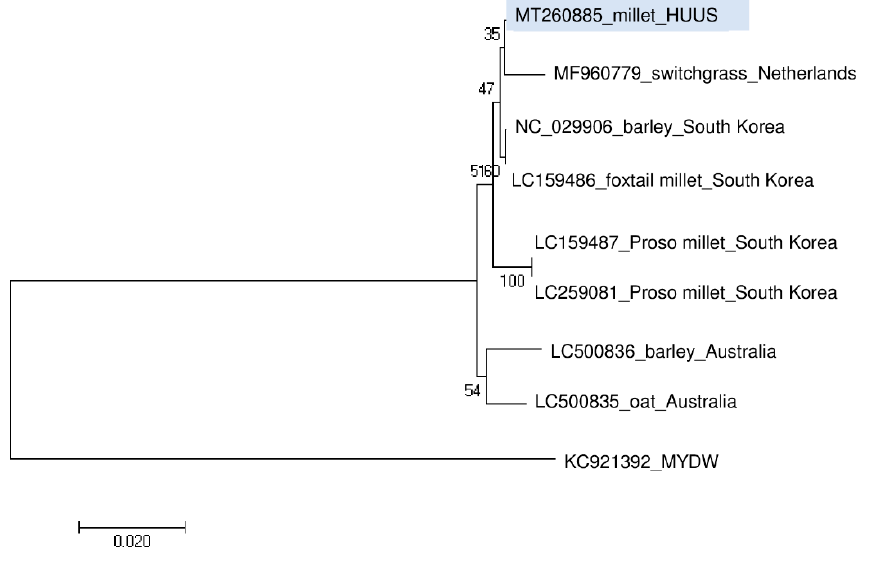
Figure 5. Results of the barley virus G (BVG) detection by sRNA HTS. ( a ) Genome organization of BVG, highlighting its coding regions and the position of the primers which were used in the RT-PCR. ( b ) shows coverage of the genome by the sequenced BVG-specific sRNA reads. The blue color shows sRNA in sense, while the red color shows sRNAs in antisense orientation. ( c ) shows size distribution of the sequenced, BVG-specific sRNA reads.